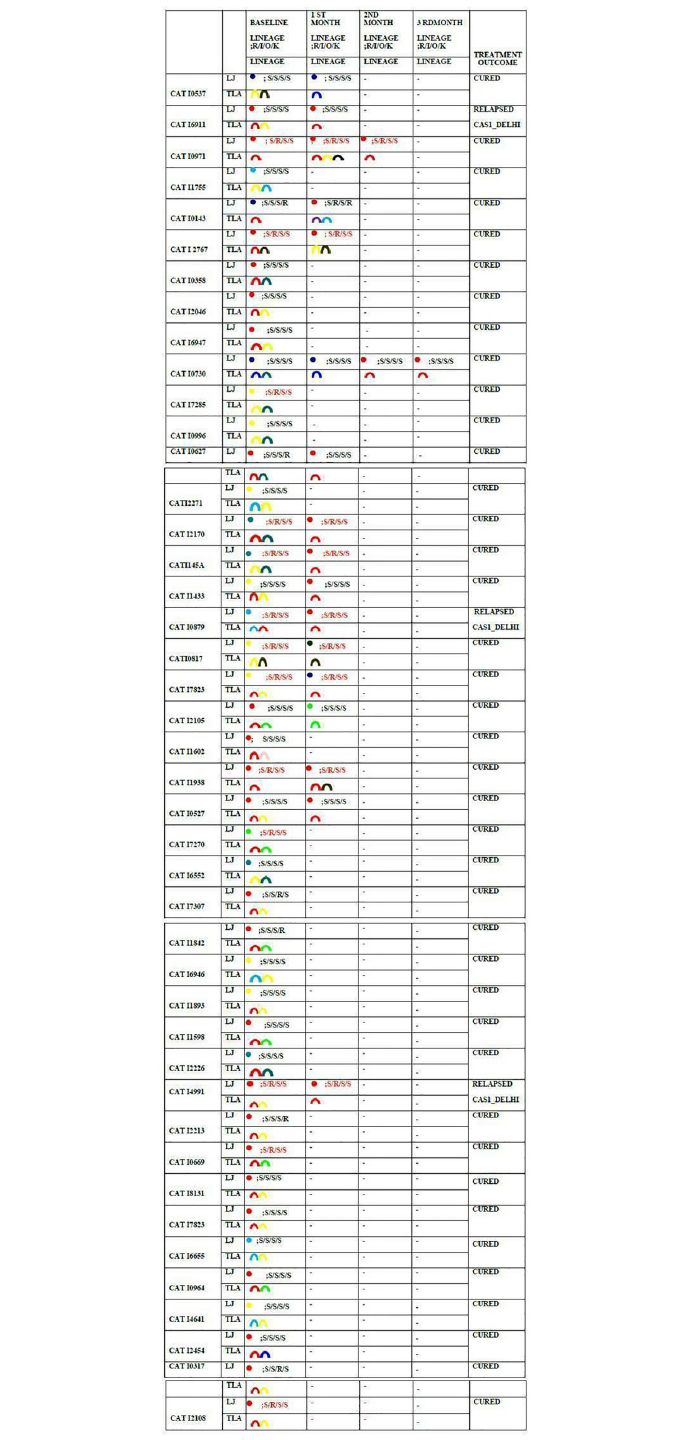
Fig 2. Serial cultures during patient follow-up on treatment, showing baseline culture spoligotyping results along with single colony spoligotyping (TLA) and phenotypic drug susceptibility profiles during different time points for patients with polyclonal infections. Baseline spoligotyping results did not always match with the results from single colony spoligotyping. A complete change of genotype was noted in the 1 st month in several patients. A change in the phenotypic drug susceptibility profile was also observed. CAS genotype constituted an increasing proportion of follow-up samples, and was the only genotype grown in 2 nd and 3 rd month cultures. [14, 15].